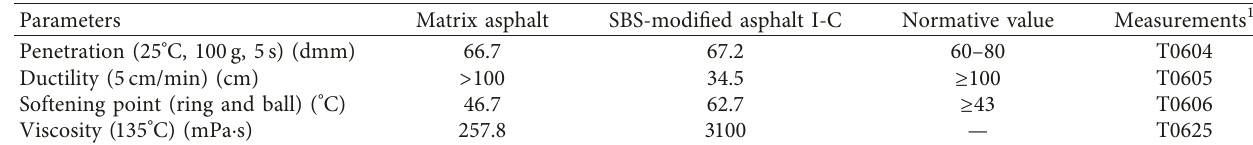
Table 2: Main indicators of the matrix asphalt and SBS-modified asphalt.